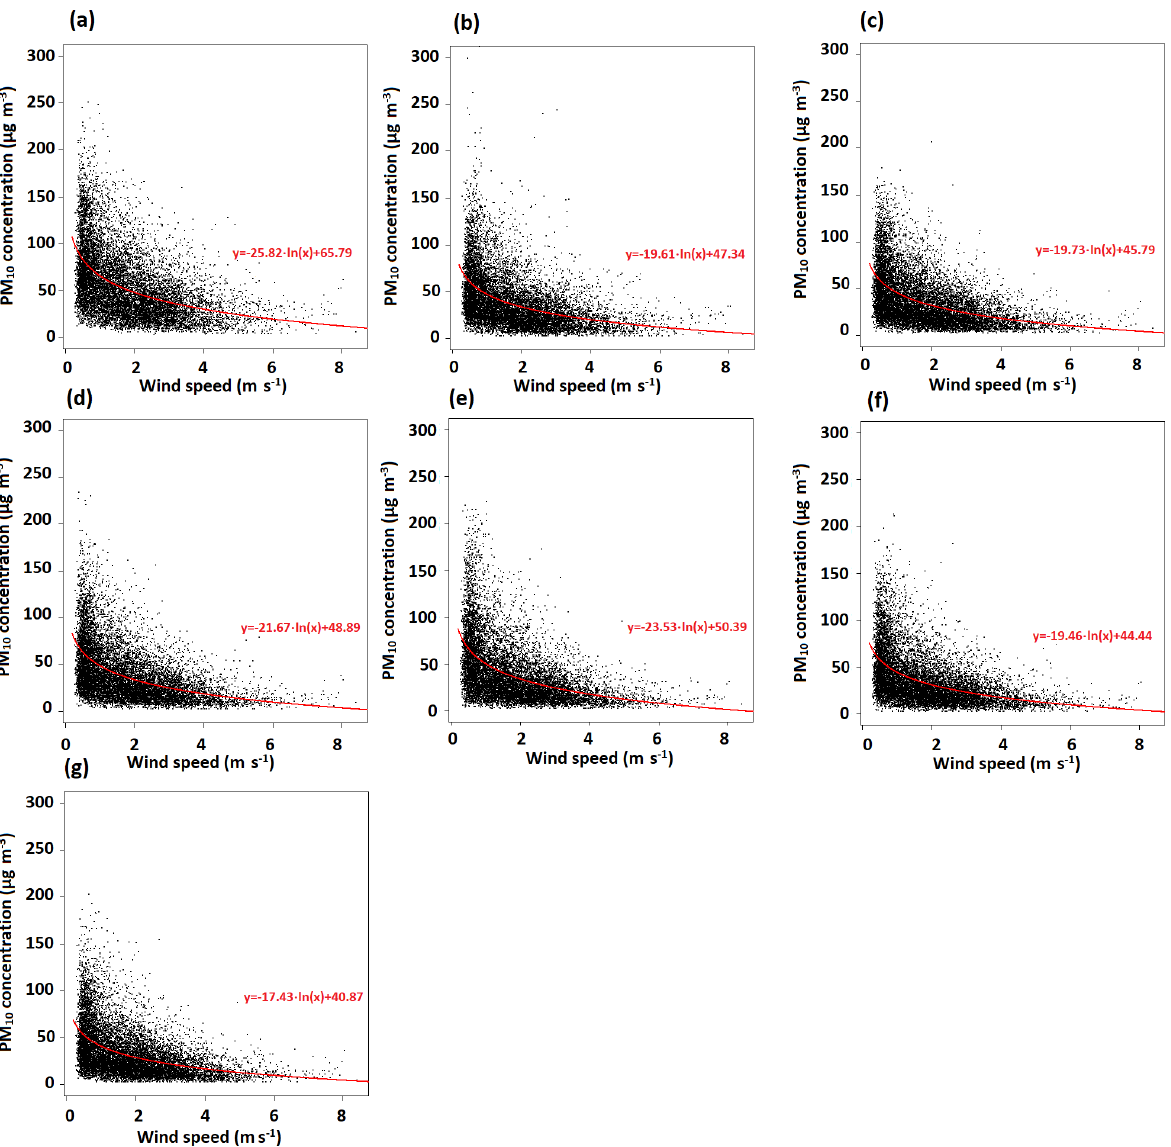
Figure A4. Analysis of hourly PM 10 concentration at air pollution stations in Kraków compared to wind speed from Reymonta St. station: (a) Krasi ´ nkiego St., (b) Dietla St., (c) Bulwarowa St., (d) Złoty Róg St., (e) Kurdwanów district, (f) Piastów district, (g) Wadów district. To presented data is fitted the logarithmic curve, and in the lower-right corner is included the curve equation.